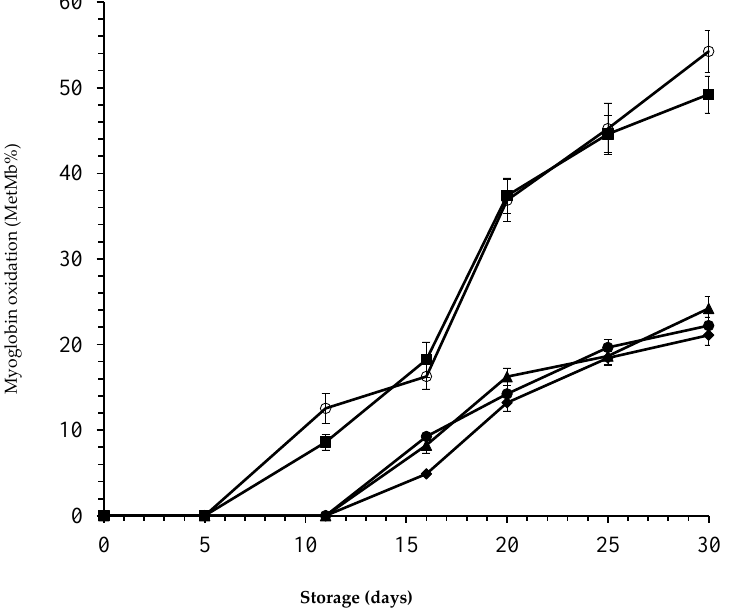
Figure 3. Pigment oxidation (surface metmyoglobin: MetMb%) in camel steaks stored at 1 ± 1 ◦ C under atmospheres of 80% O 2 and 20% CO 2 after treatment with 25 ppm nisin ( ); 500 ppm laper .OLE ( ); 25 ppm nisin/500 ppm laper .OLE ( ); 25 ppm nisin/1000 ppm laper .OLE ( ); or untreated samples ( ). Error bars represent the standard deviation.